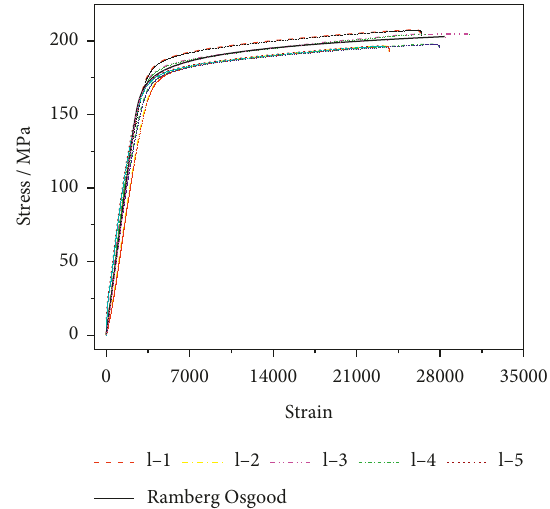
Figure 1: Comparison between theoretical and experimental